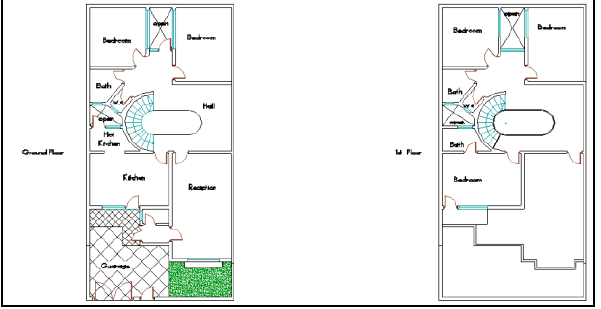
Figure 9. The plan of the both floors in single house in the Goollun city Housing Project. (By